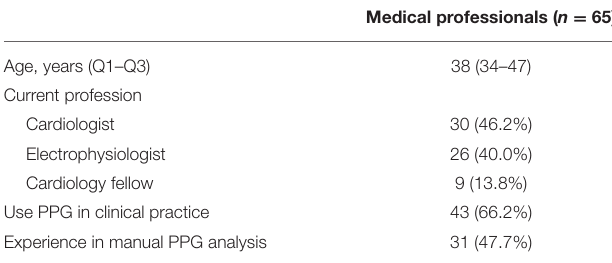
TABLE 1 | Characteristics of the study